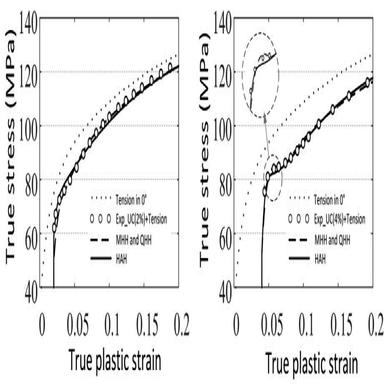
Comparison of the simulated and experimental stress–strain curves from tension tests prestrained by compression (2% and 4%) together with the monotonic loading curve.